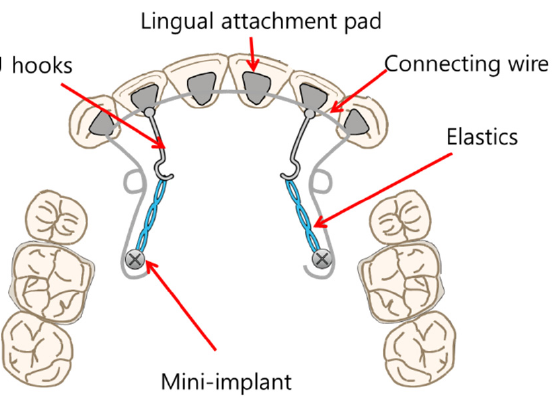
Figure 3. Double J retractor (DJR).